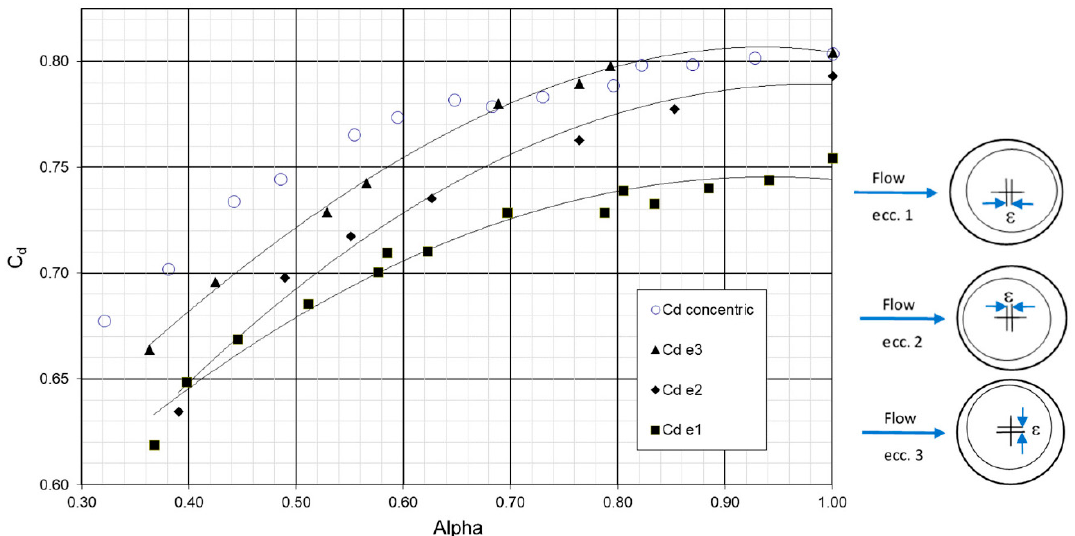
Figure 9. Affect of step concentricity with main port on discharge coefficient.